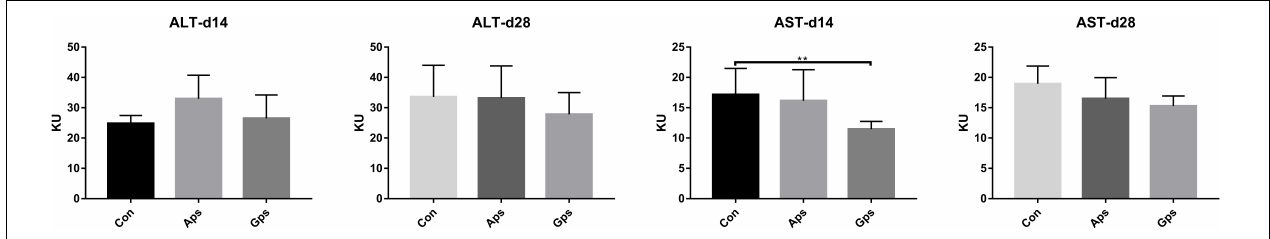
FIGURE 1 | Effect of Aps and Gps on the serum liver function indexes in weaned piglets. Con represents the control piglets on d 14 and 28, respectively; Aps represents the piglets supplemented with the astragalus polysaccharide on d 14 and 28, respectively; Gps represents the piglets supplemented with ginseng polysaccharide on d 14 and 28, respectively. ∗∗ Means significant difference ( P < 0.01). Values means n = 6 for the analysis of serum liver function indexes.